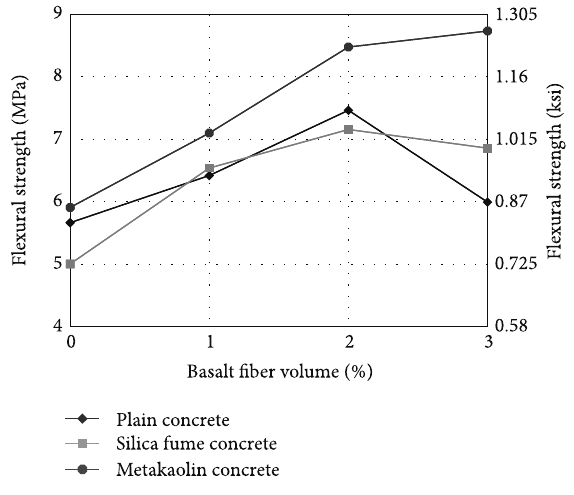
Figure 8: Variation in the flexural